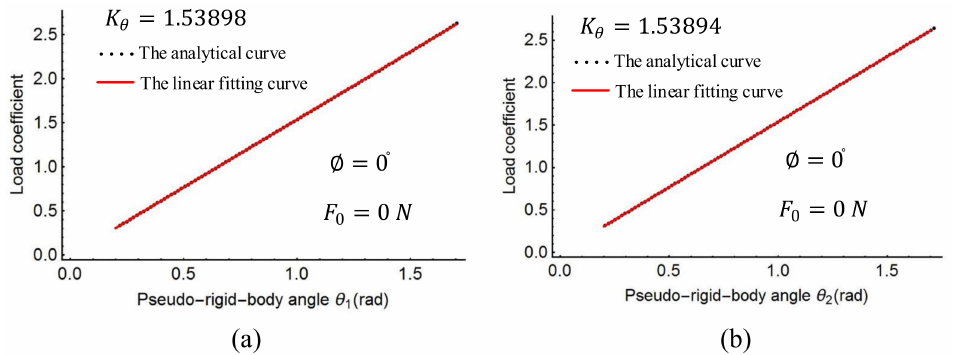
Figure 9. Linear regression of stiffness coefficient with action moment: ( a ) rotation joints P 1 , ( b ) rotation joint P 2